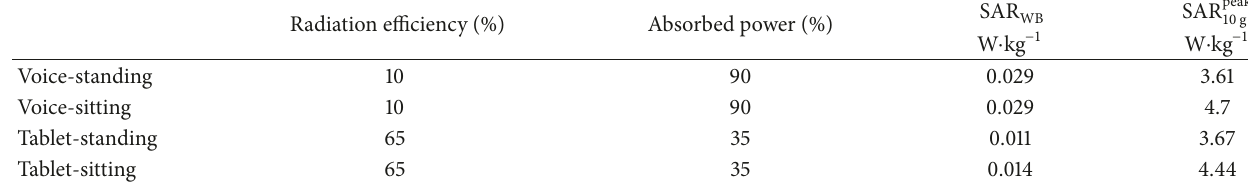
normalized to an input power of 1W. WB